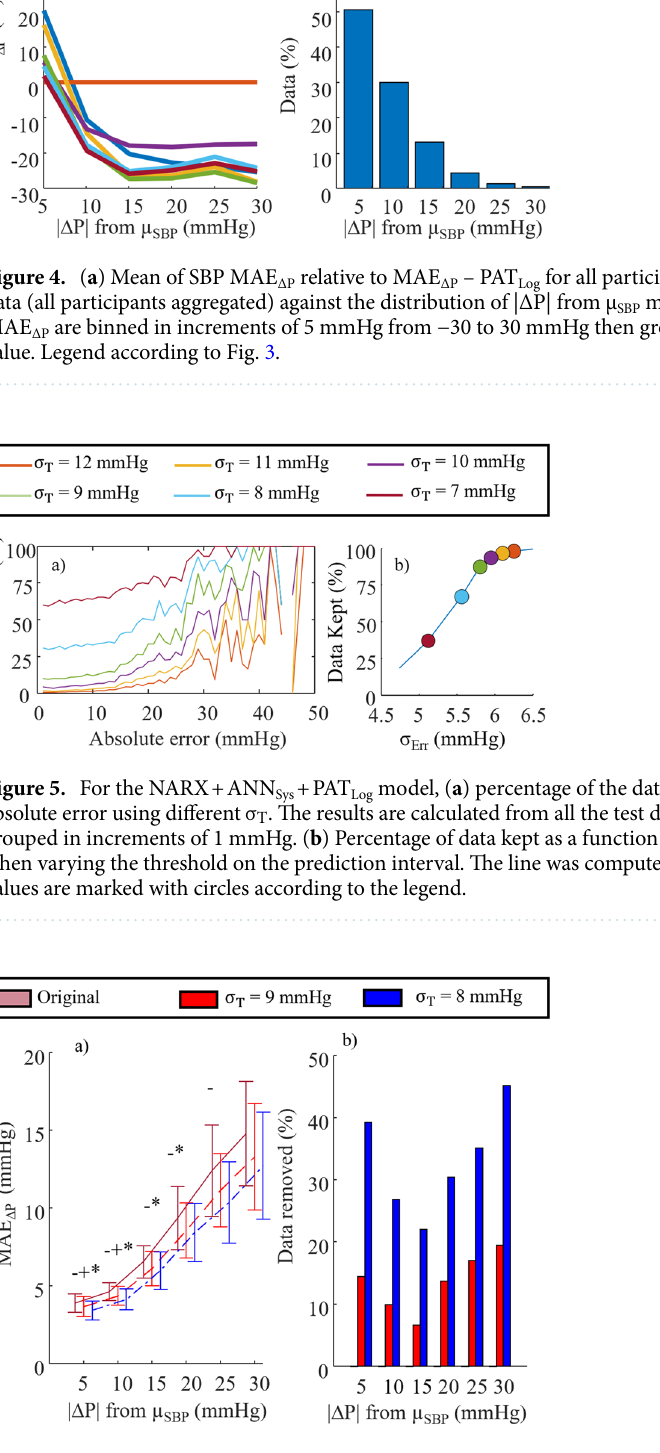
Figure 6. For the NARX + ANN Sys + PAT Log model, ( a ) mean and standard deviation of MAE ΔP for all participants, and ( b ) percentage of data removed from each bin versus |∆P| from µ SBP measured throughout the day using different threshold ( σ T ). In ( a ) lines represent the mean of all subjects and the error bars show ± SD. t-test with p < 0.05/3 (*). Original vs σ T = 9 mmHg, (−), original vs σ T = 8 mmHg, and ( +) σ T = 8 mmHg vs σ T = 9 mmHg (p <